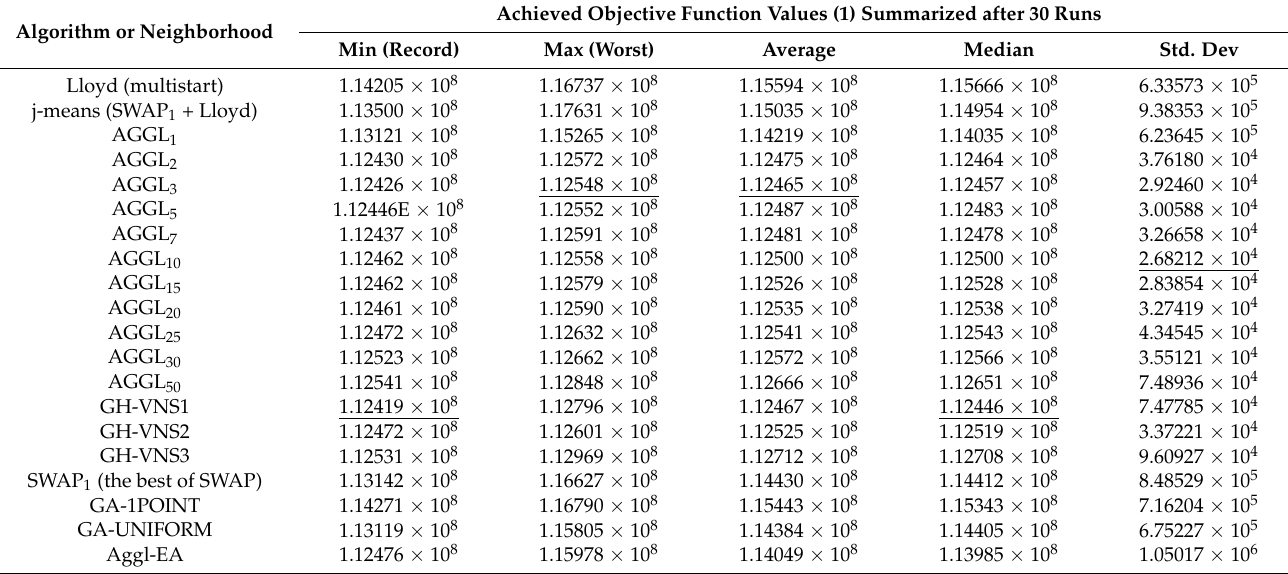
Table A5. Comparative results for S1 dataset. 5000 data vectors in R 2 , p = 50 centers, time limitation 1 s. Algorithm or Neighborhood